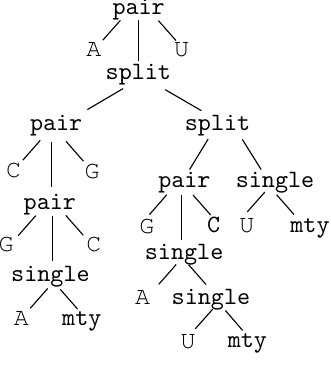
Figure 6. Core term for secondary structure of Figure